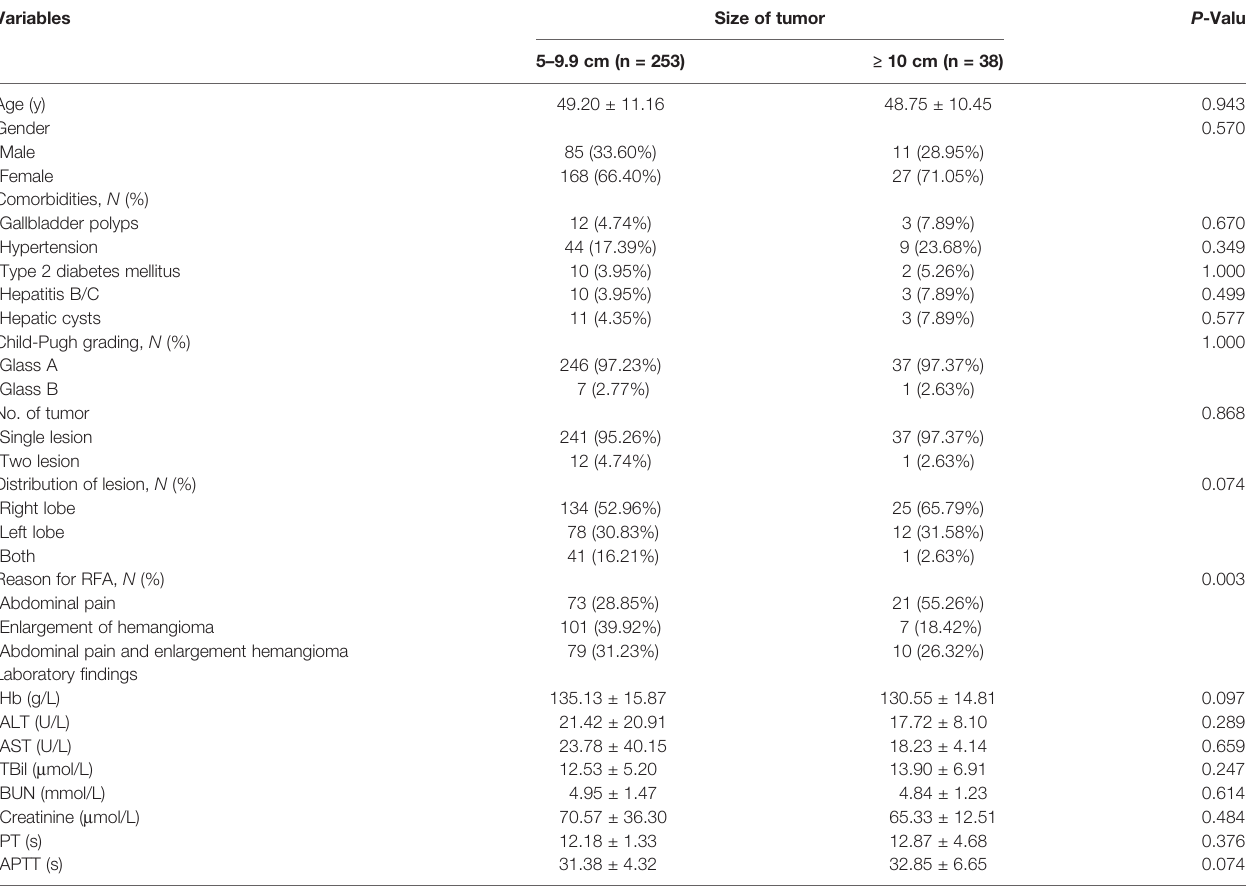
TABLE 2 | The demographic characteristics of 291 patients in the